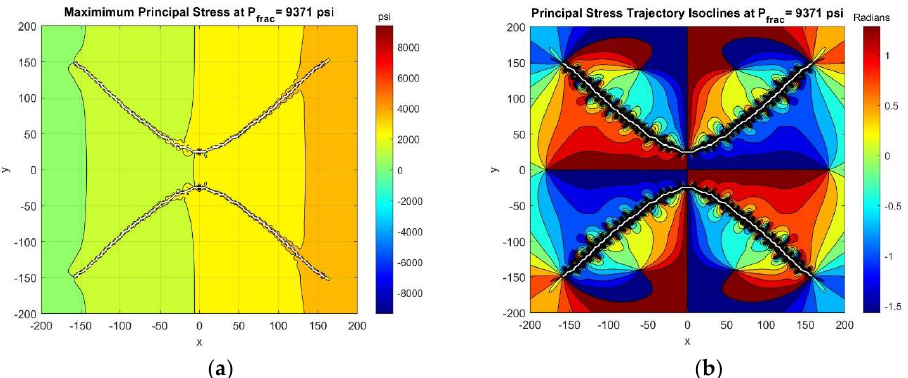
Figure 13. TLSM results at the end of injection showing ( a ) maximum principal stress, and ( b ) principal stress trajectory isoclines at t = 4.583 min. TLSM results were generated in 50.101 s including post-processing.